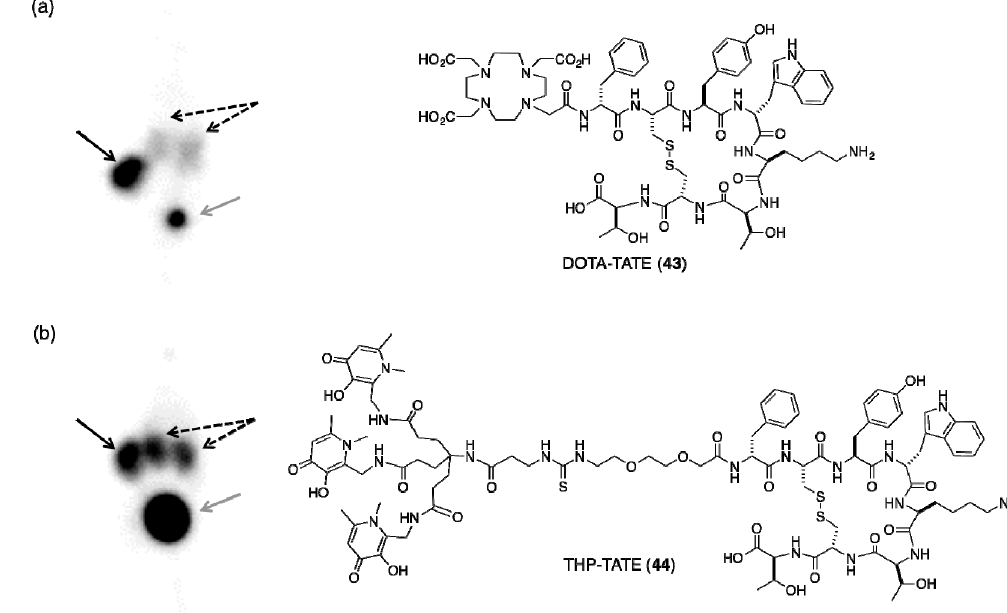
Figure 12. Representative PET maximum intensity projections of Balb/c nu/nu mice bearing AR47J tumours on the right flank 1 h PI of: ( a ) [ 68 Ga(DOTA-TATE)]; and ( b ) [ 68 Ga(THP-TATE)]. Black arrow, tumour; grey arrow, bladder; dashed arrow, kidneys. Reprinted with permission under a Creative Commons Attribution (CC-BY) License from Ma, M.T.; et al. Rapid kit-based 68 Ga-labelling and PET imaging with THP-Tyr 3 -octreotate: a preliminary comparison with DOTA-Tyr 3 -octreotate. EJNMMI Res. 2015 , 5 , 52. Copyright.